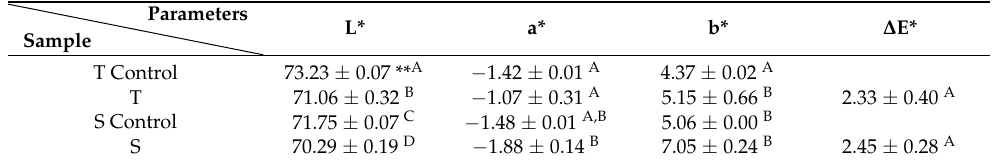
Table 1. Color parameters for